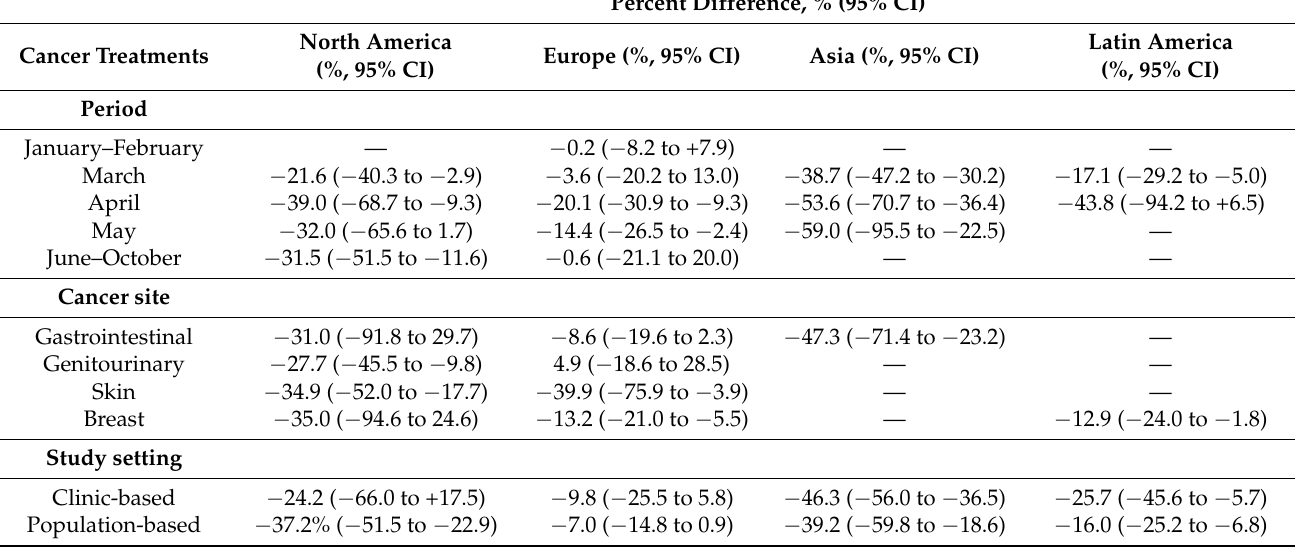
Table 2. Weighted average variation of overall oncological treatment performed from January to October 2020 compared to the pre-pandemic period for North America, Europe, Asia, and Latin America by period, cancer site, and study